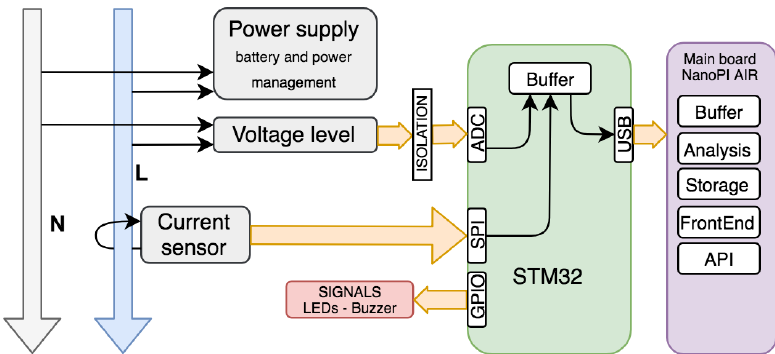
Figure 4. Flowchart for the electronic scheme.